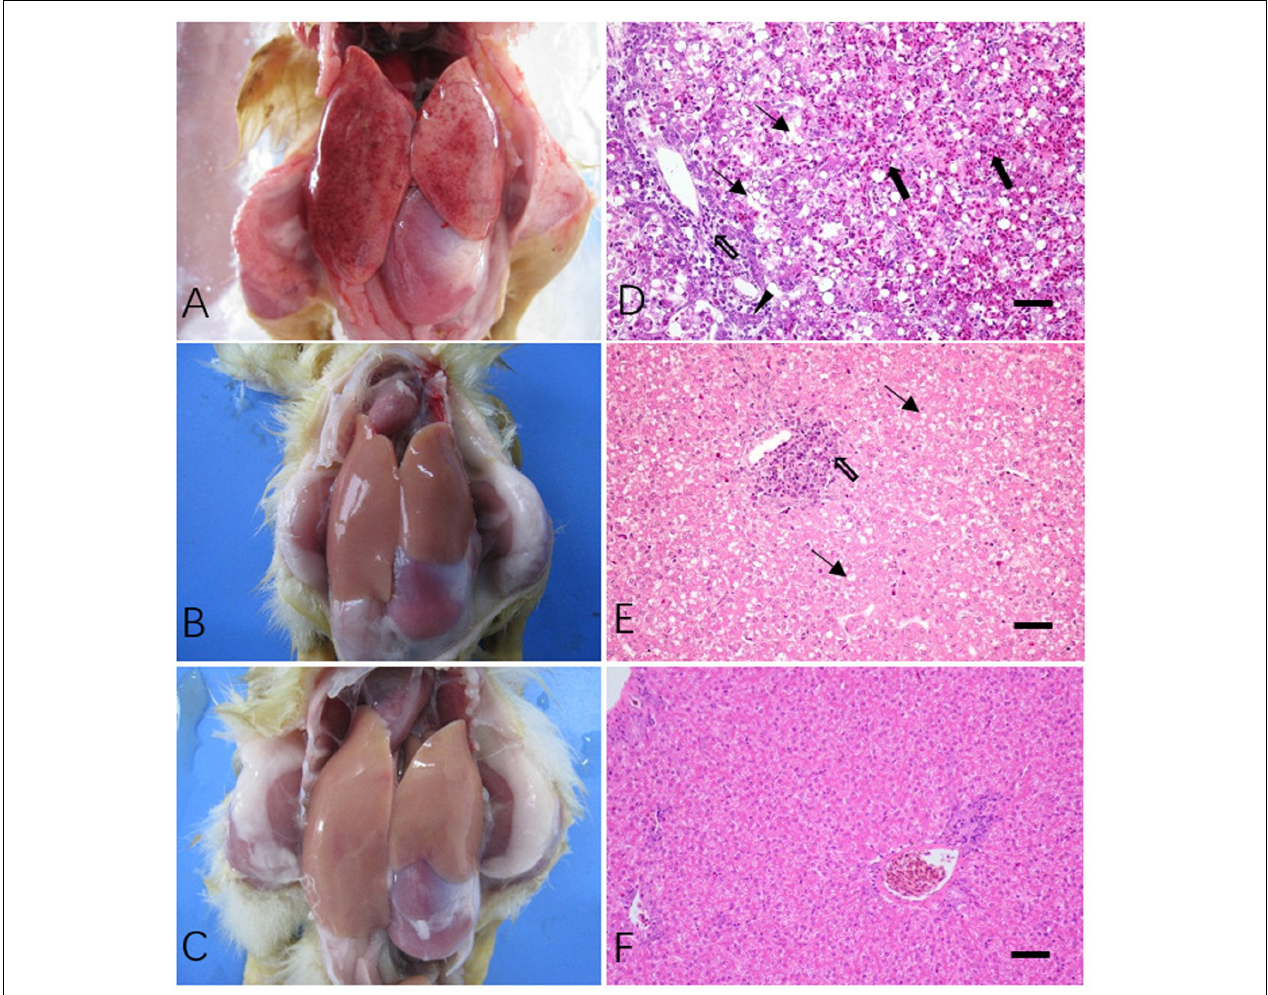
FIGURE 2 | Gross and microscopic lesions of livers in Z8S2 and Z8R2 ducklings infected with DHAV-3 at 30 hpi. (A) Redness and numerous hemorrhagic spots in livers from dead ducklings of Z8S2 and Z8R2 flocks. (B) No significant cross lesions in livers from live ducklings of Z8S2 and Z8R2 flocks. (C) A liver from mock-infected ducklings. (D) Hepatocyte necrosis (arrow), hemorrhage, congestion (black arrow), bile duct hyperplasia (triangle) and significant inflammatory cell infiltration (hollow arrow) in dead ducklings of both Z8S2 and Z8R2 flocks. (E) Slight vacuolar degeneration (arrow) and focal lymphocytic aggregations (hollow arrow) in live ducklings of both Z8S2 and Z8R2 flocks. (F) No gross and microscopic lesions in livers of mock-infected ducklings. Bar = 50 µ